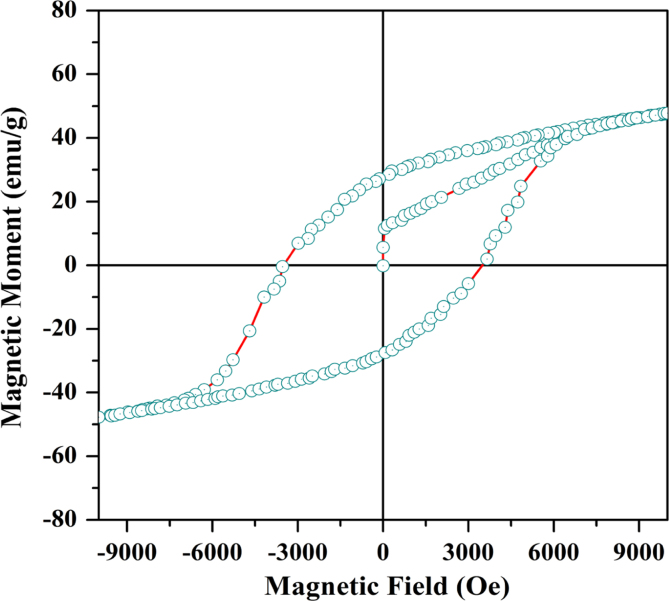
Magnetic hysteresis loop of polycrystalline La0.2Pb0.7Fe12O19 ceramic being sintered at 1000 °C for 1 h and subsequently annealed in O2 for 9 h. The measurement was performed at room temperature.